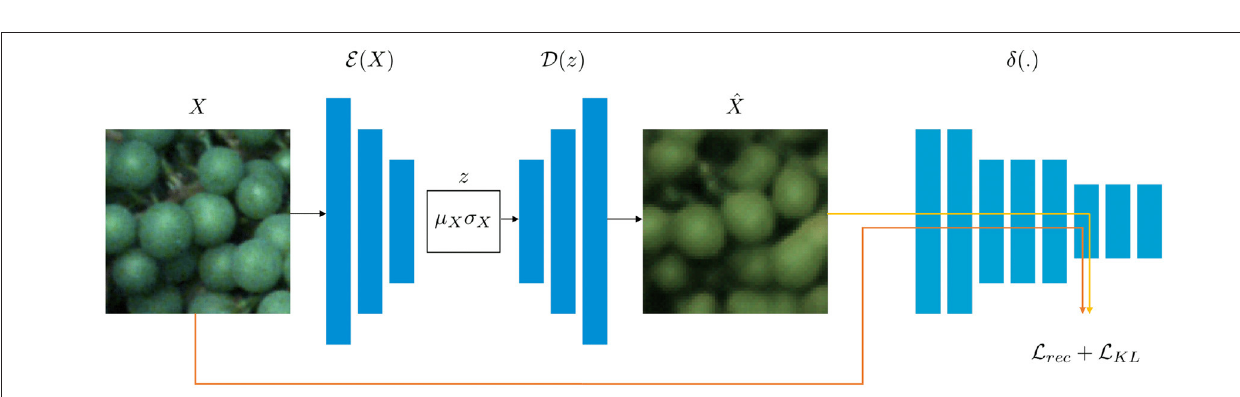
FIGURE 4 | The architecture of our VAE is realized by two neural networks (Hinton and Salakhutdinov, 2006), namely an encoder network E , and a decoder network D . While D embeds the input data X with dimensionality M in a latent representation z of dimensionality m (where m ≪ M ), D is able to restore the data ˆ X given the latent representation z . Both X and ˆ X are fed into a VGGNet (Simonyan and Zisserman, 2014) to calculate the reconstruction loss L rec . In addition, a KL-Divergence loss L KL is